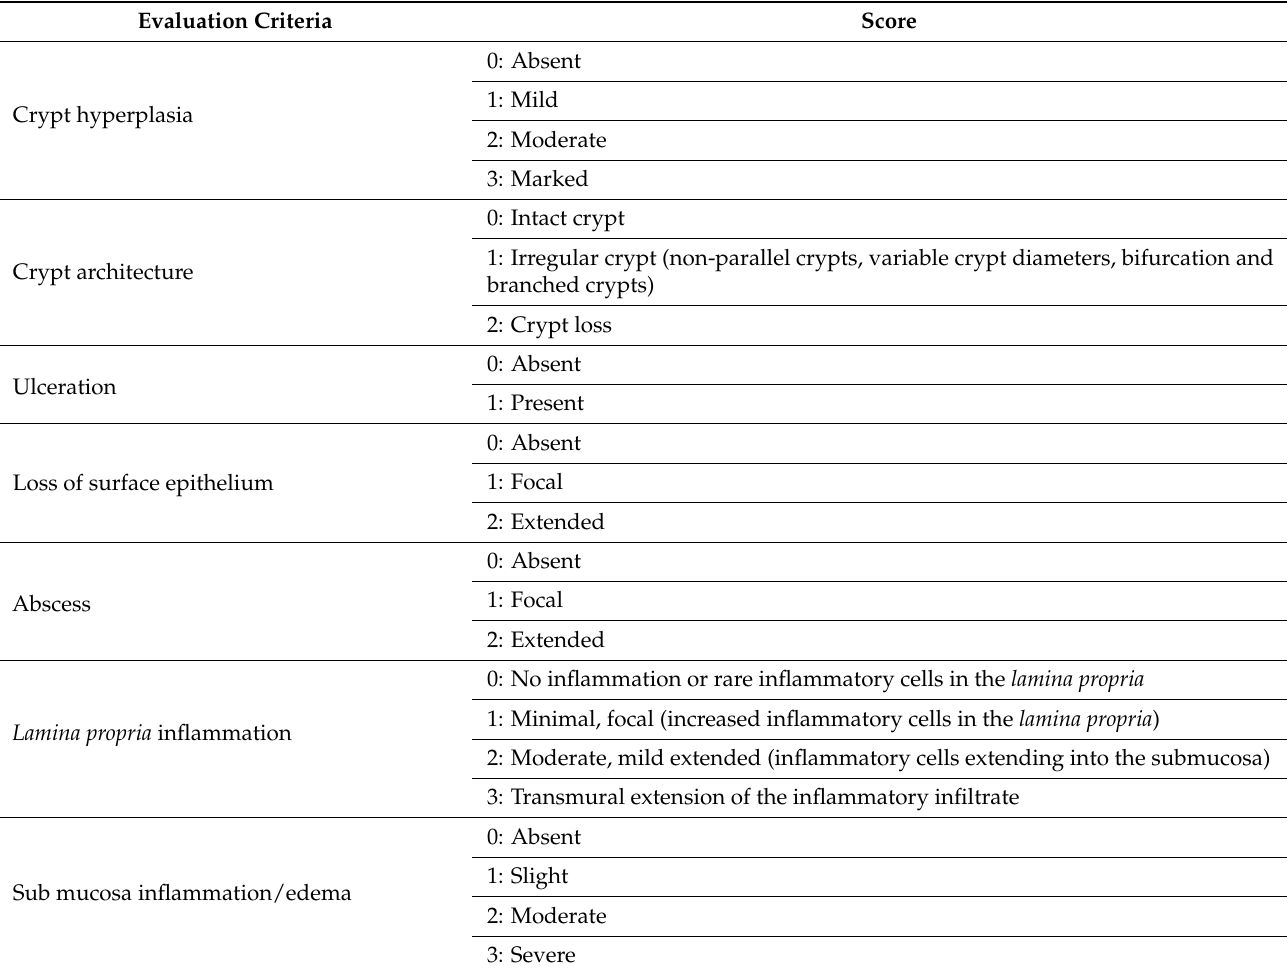
Table 2. Inflammation